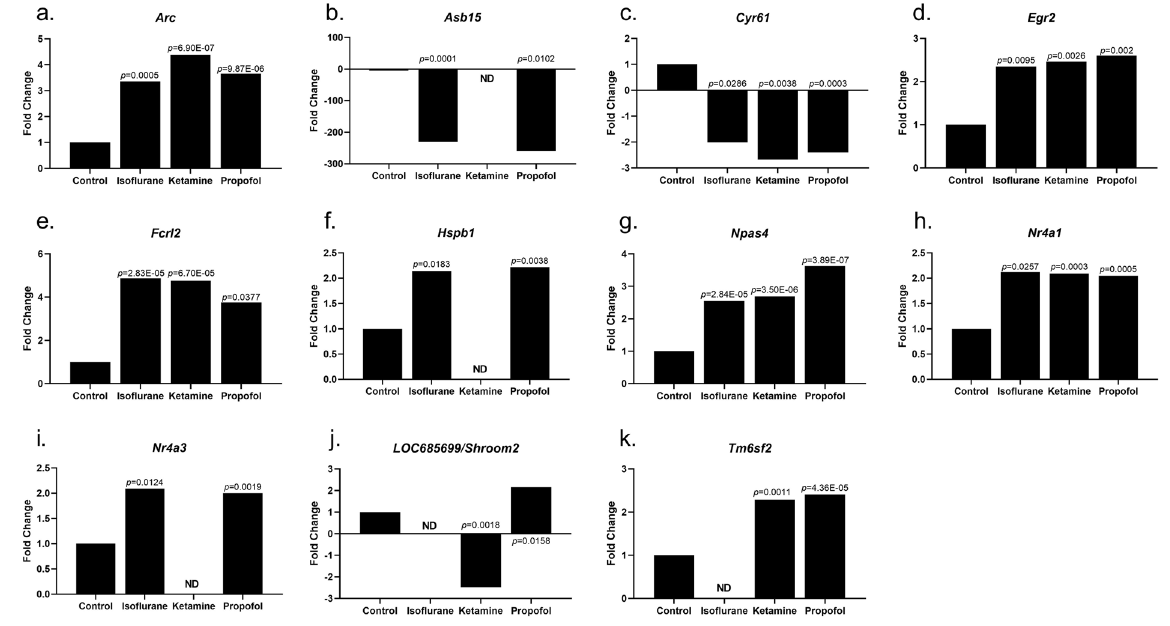
Figure 3. Fold change gene expression changes for Acute treatment compared to Acute control, ND – not detected (a) Arc ; ( b ) Asb15 ; ( c ) Cyr61 ; (d) Egr2 ; (e) Fcrl2 ; (f) Hspb1 ; (g) Npas4 ; (h) Nr4a1 ; (i) Nr4a3 ; (j) LOC685699/Shroom ; ( k ) Tm6sf2 .